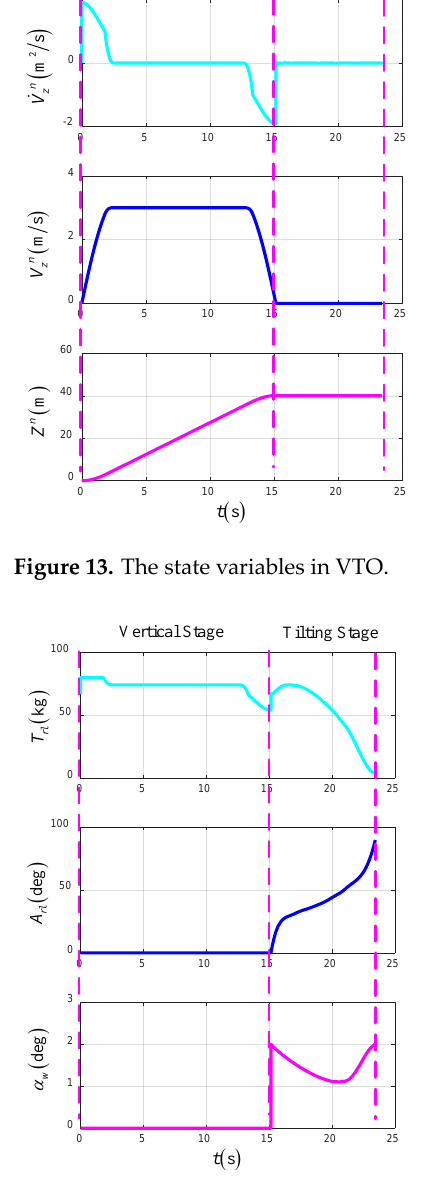
Figure 14. The control variables in VTO.